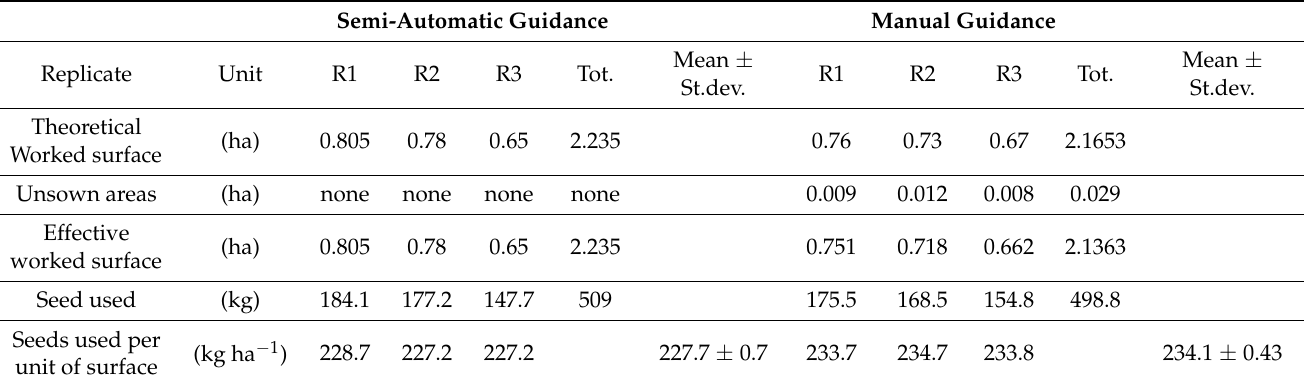
Table 2. Surface and seed utilised in each replicate.